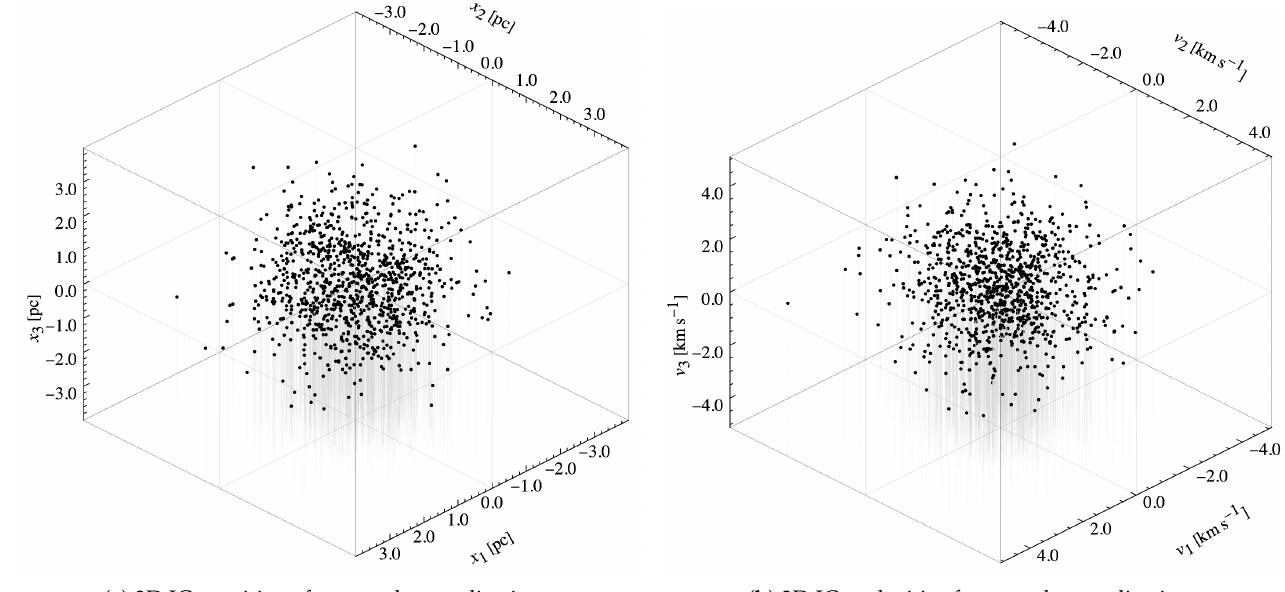
Figure 1. Cluster IC positions and velocities. Both the position and velocities correspond to a sample of an isotropic Maxwell–Boltzmann distribution, further expanded in Figure 3. Note that there is no correlation at the IC time between the masses and positions, so more massive PBHs are not yet favoured to cluster closer to the cluster barycentre. Moreover, the velocity distribution computation is illustrated in Figure 5 and while Figure 6 shows the actual velocity